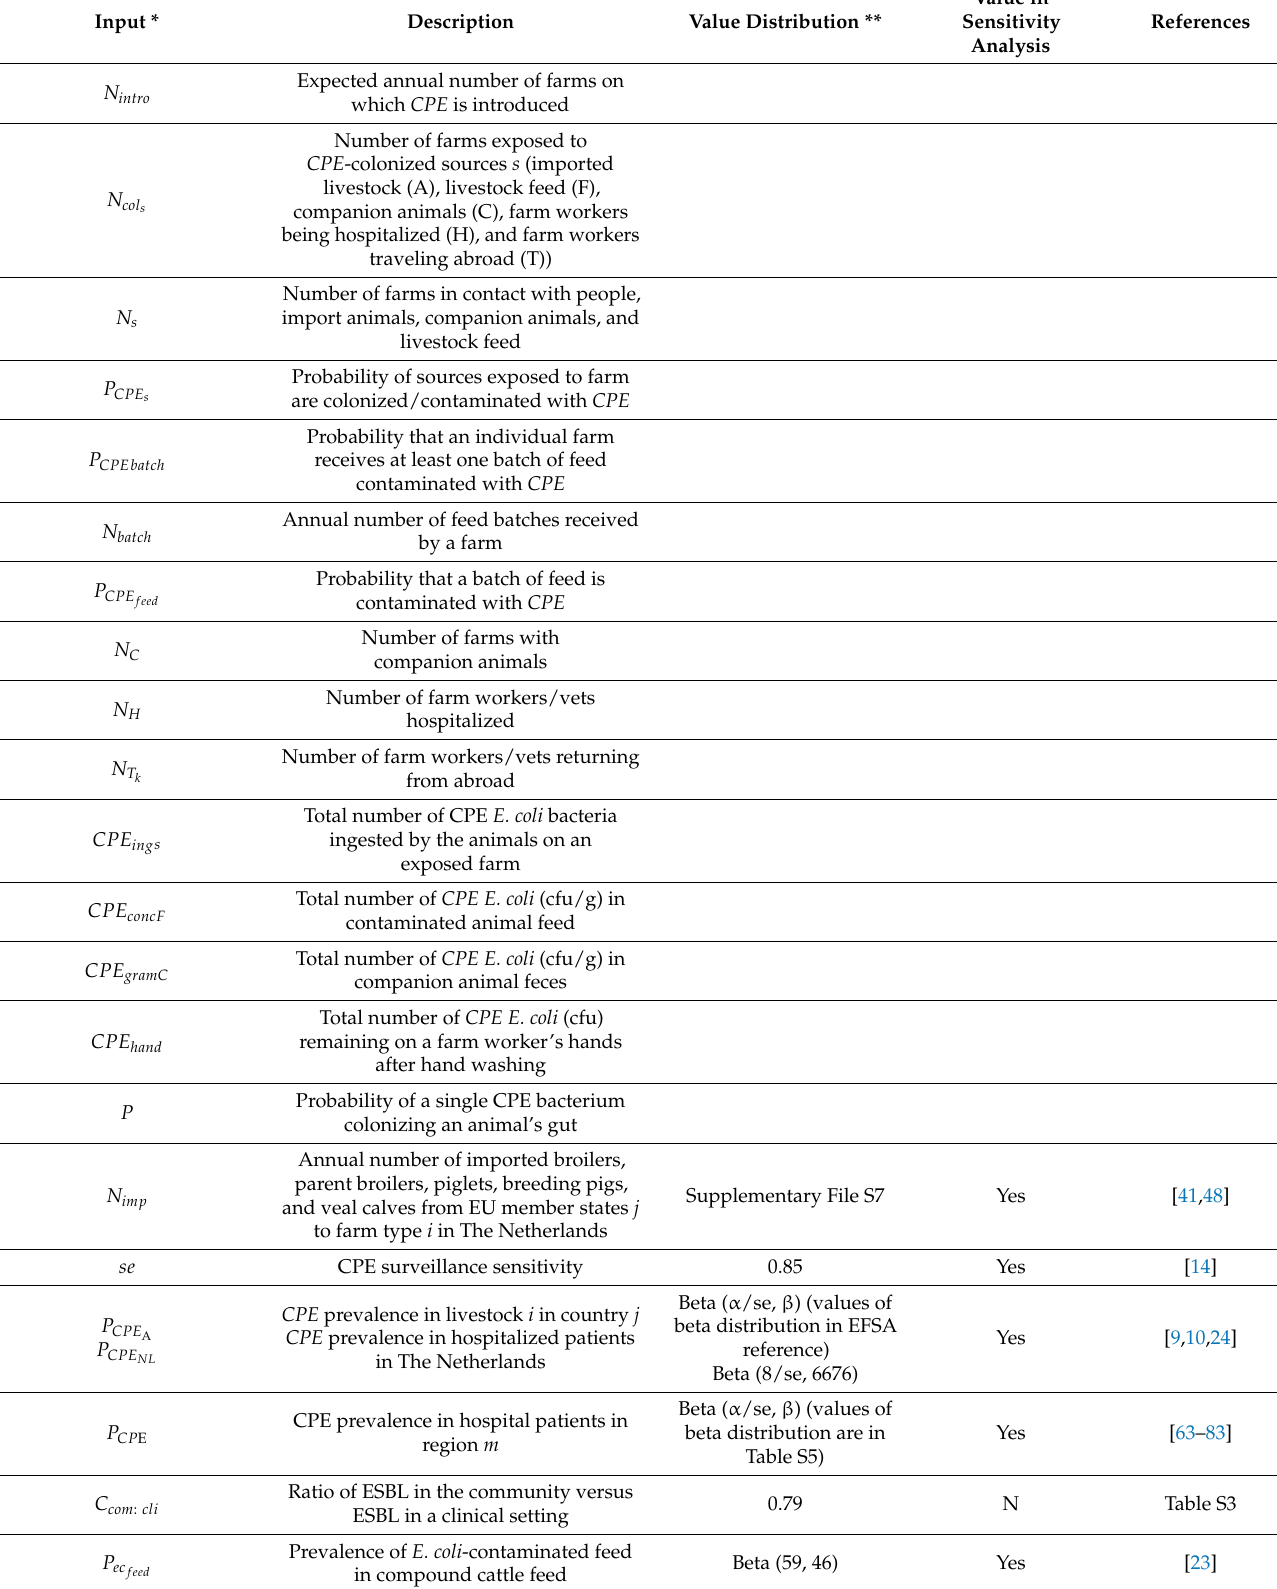
Table 4. Input parameters for the model to assess the risk of CPE introduction into Dutch livestock